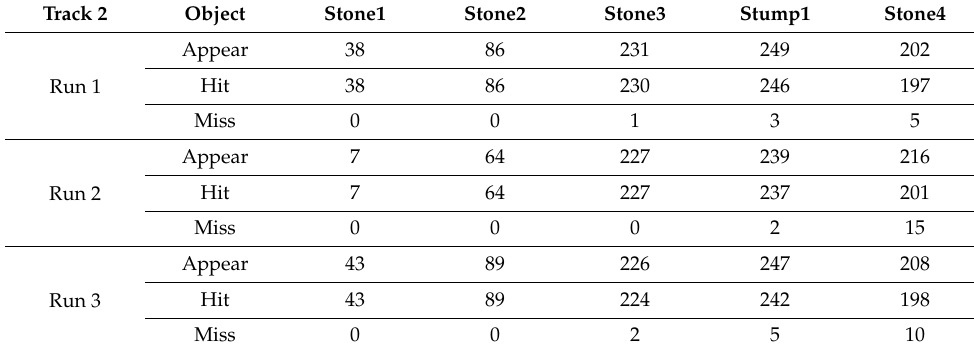
Table 3. The detection result of the detector on the target objects in Track 2.